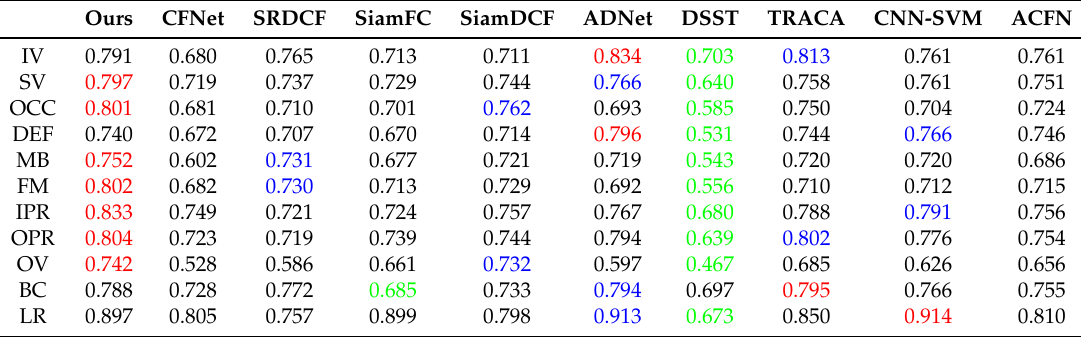
Figure 8. Comparison of precision plots over 11 attributes. Table 2. Distance precision (DP) scores of the 10 trackers in terms of different attributes: The top three results are shown in Red, Blue, and